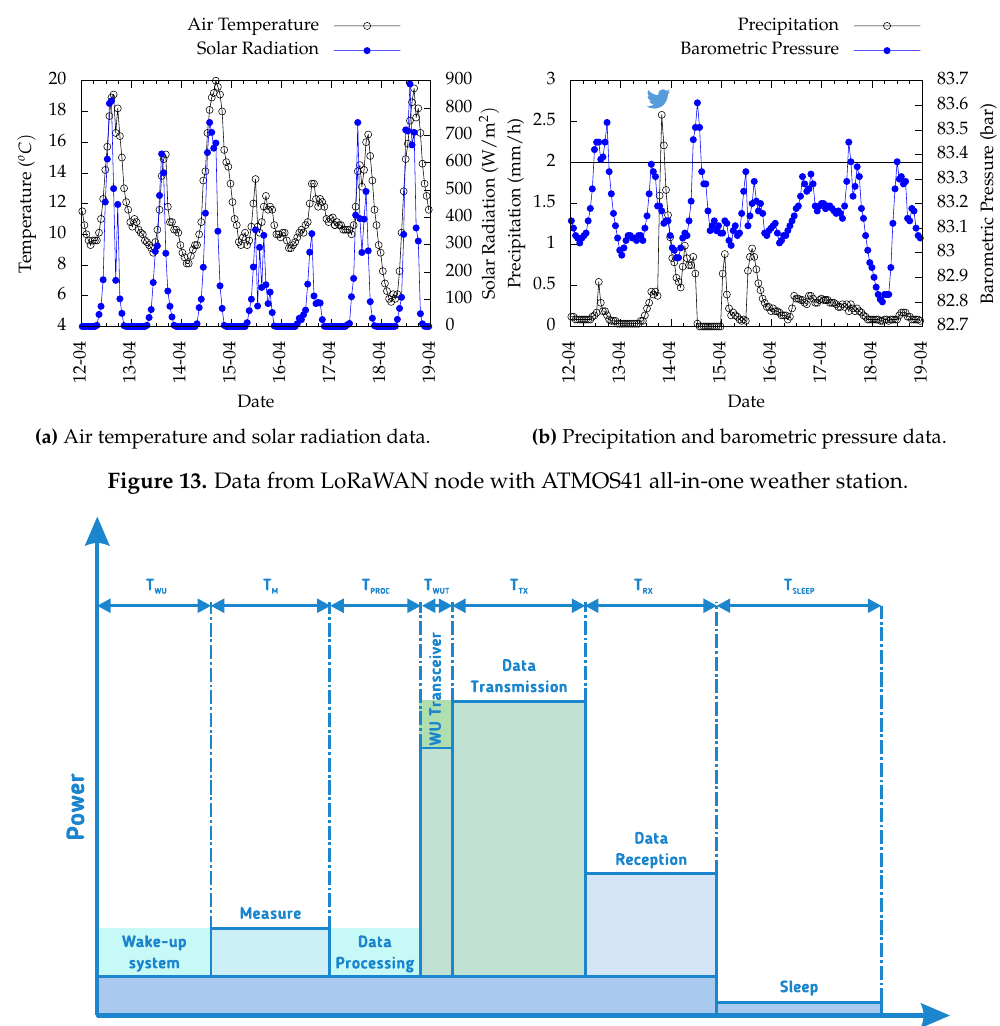
Figure 12. Output data from the Watermark sensor.